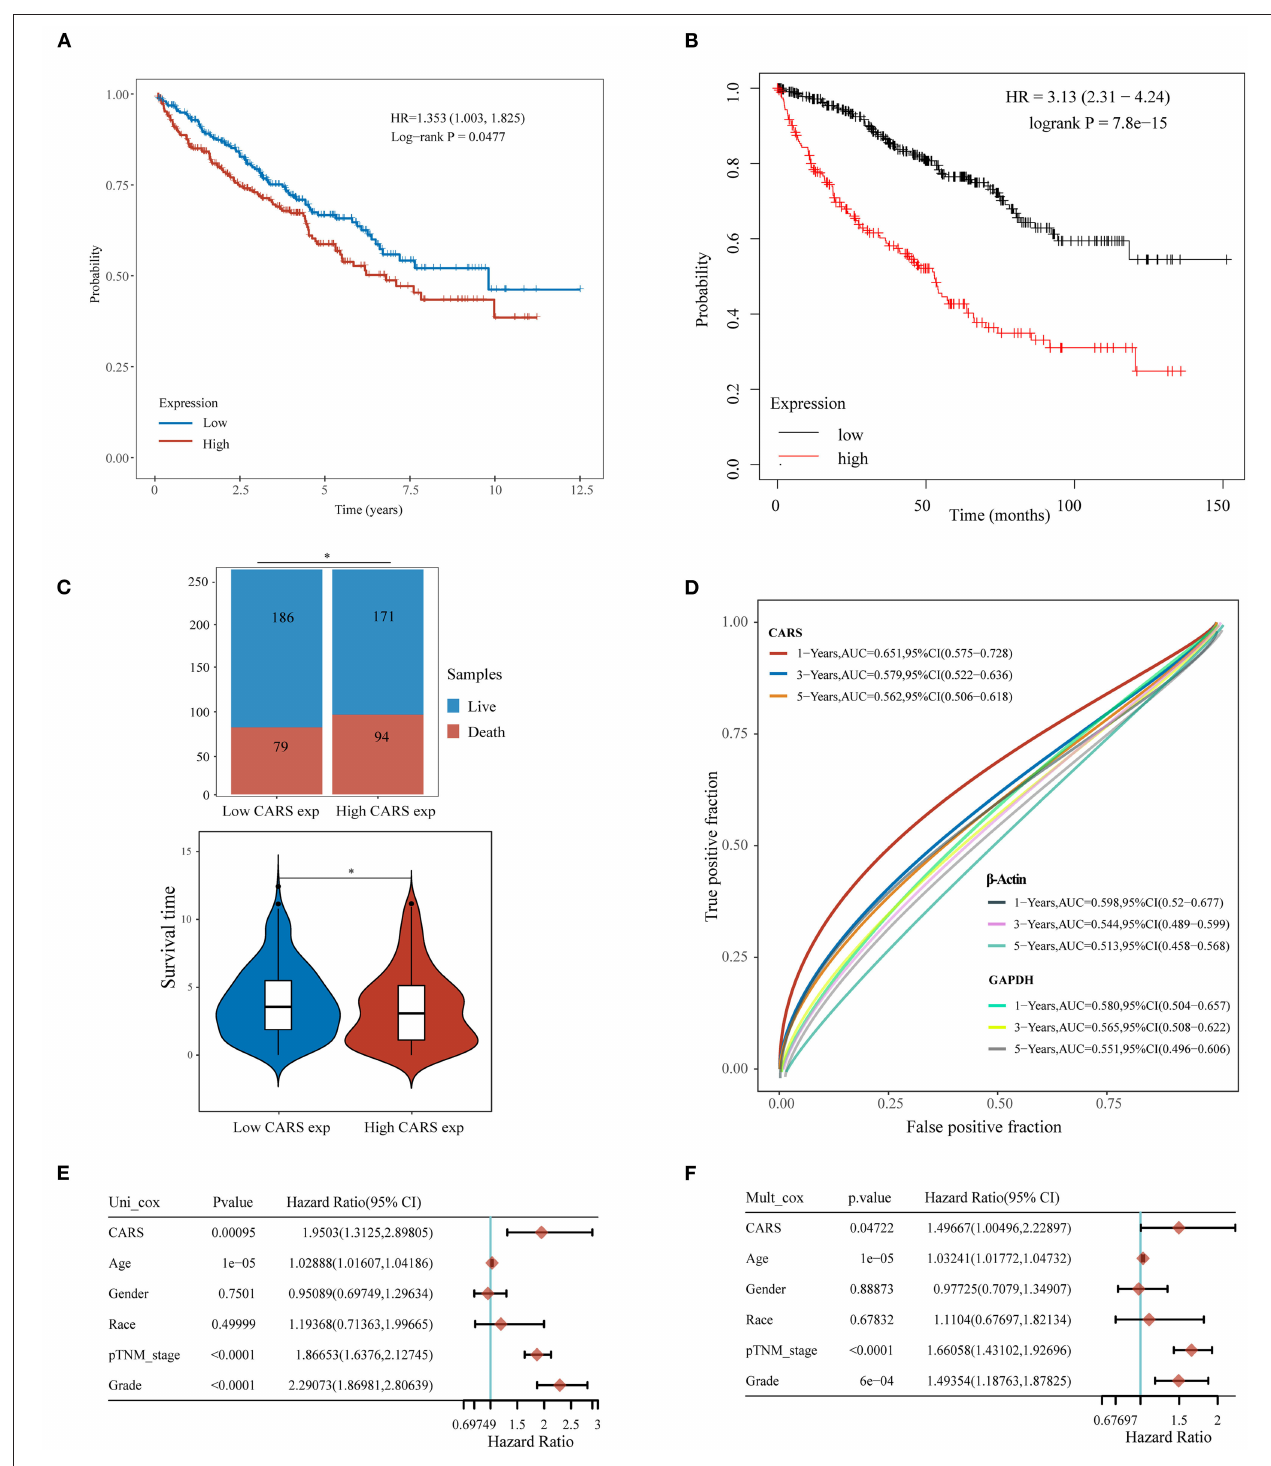
FIGURE 6 | Upregulated CARS expression is associated with poor outcomes of clear cell renal cell carcinoma (ccRCC). (A,B) The Kaplan–Meier analysis of ccRCC patients with high and low CARS expression level in the TCGA cohort (A) and Kaplan–Meier plotter database (B) . (C) The stacked bar chart and violin plot visualized the proportion of live/death and survival time in high/low CARS groups in ccRCC patients. (D) Time-dependent receiver operating characteristics analysis of CARS and the two most common housekeeping genes, GAPDH and β -Actin. (E,F) Forest plots based upon the outcomes of univariate (E) and multivariate Cox regression (F) of CARS expression and other clinicopathological factors. * p <